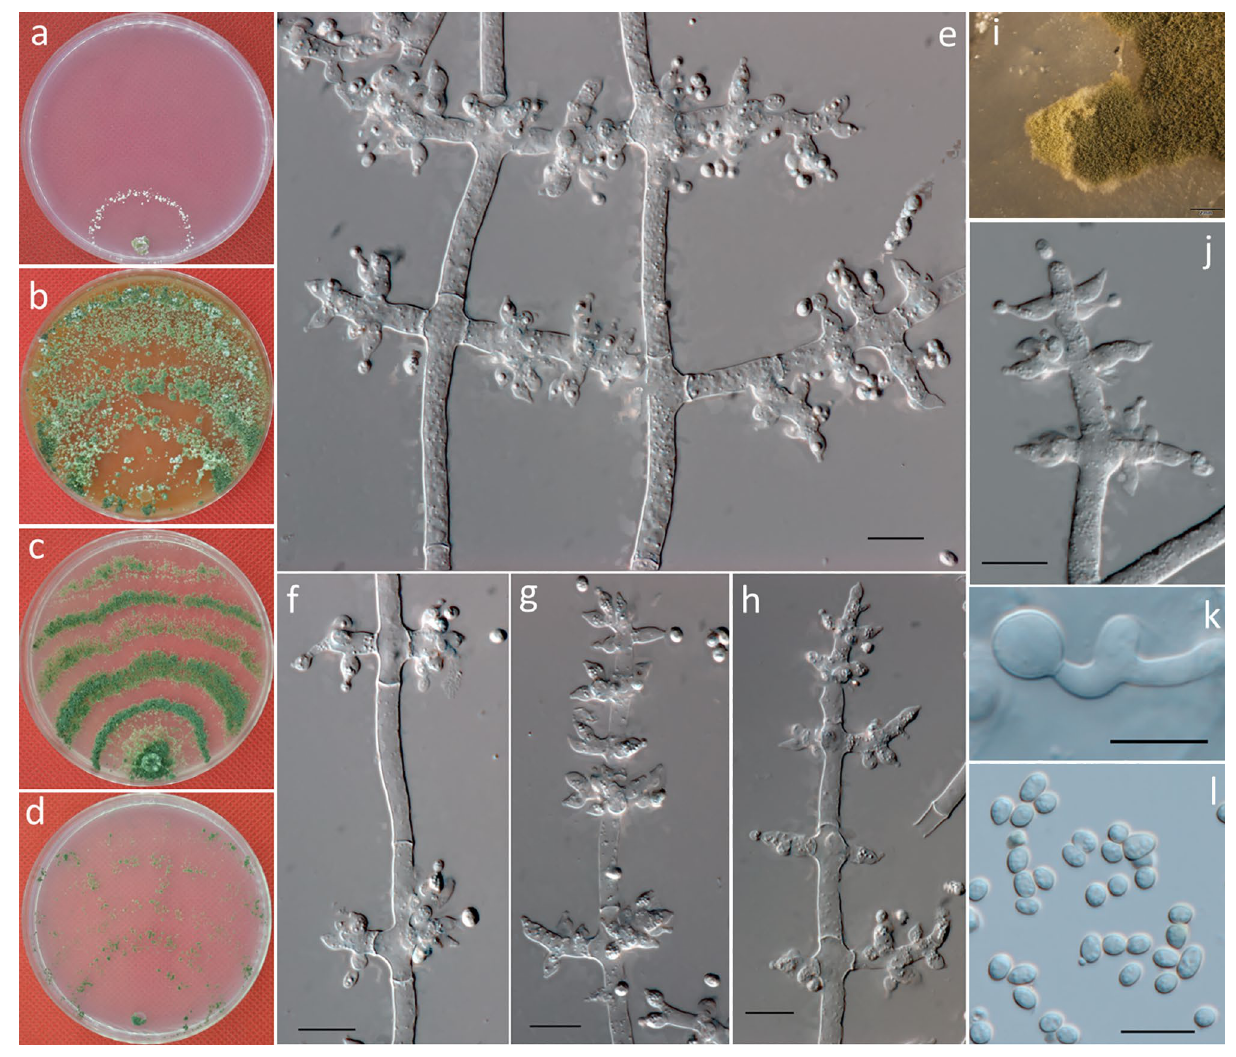
Figure 8. Cultures and asexual morph of Trichoderma polysporum . ( a–d ) Cultures at 20 °C [( a ) on CMD, 7 days; ( b ) on MEA, 15 days; ( c ) on PDA, 15 days; and ( d ) on SNA, 15 days]. ( i ) Conidiation tuft (PDA, 15 days). ( e – h,j ) Conidiophores and phialides (CMD, 5–7 days). ( k ) Chlamydospores (CMD, 7 days). ( l ) Conidia (PDA, 6 days). Scale bars: ( i ) = 2 mm; ( e–h,j ) = 10